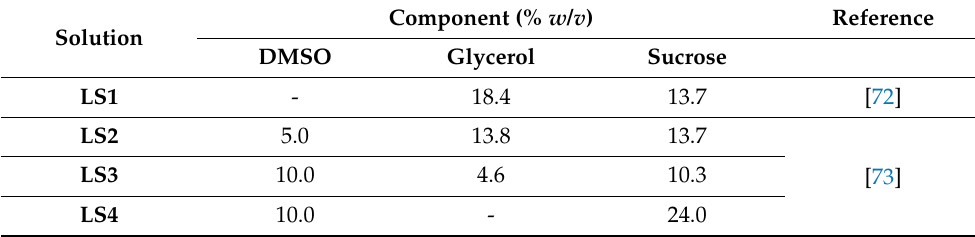
Table 2. Composition of Most common loading solutions